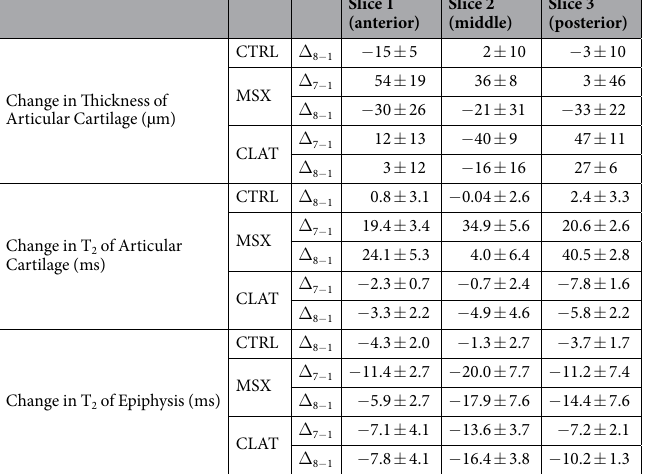
0.8 ± 3.1 − 0.04 ± 2.6